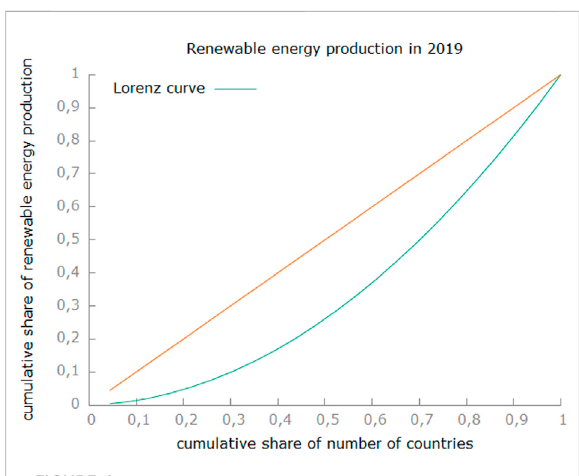
FIGURE 4 Lorenzconcentrationcurvesforvolumeofrenewableenergy production in countries of Central and Eastern Europe